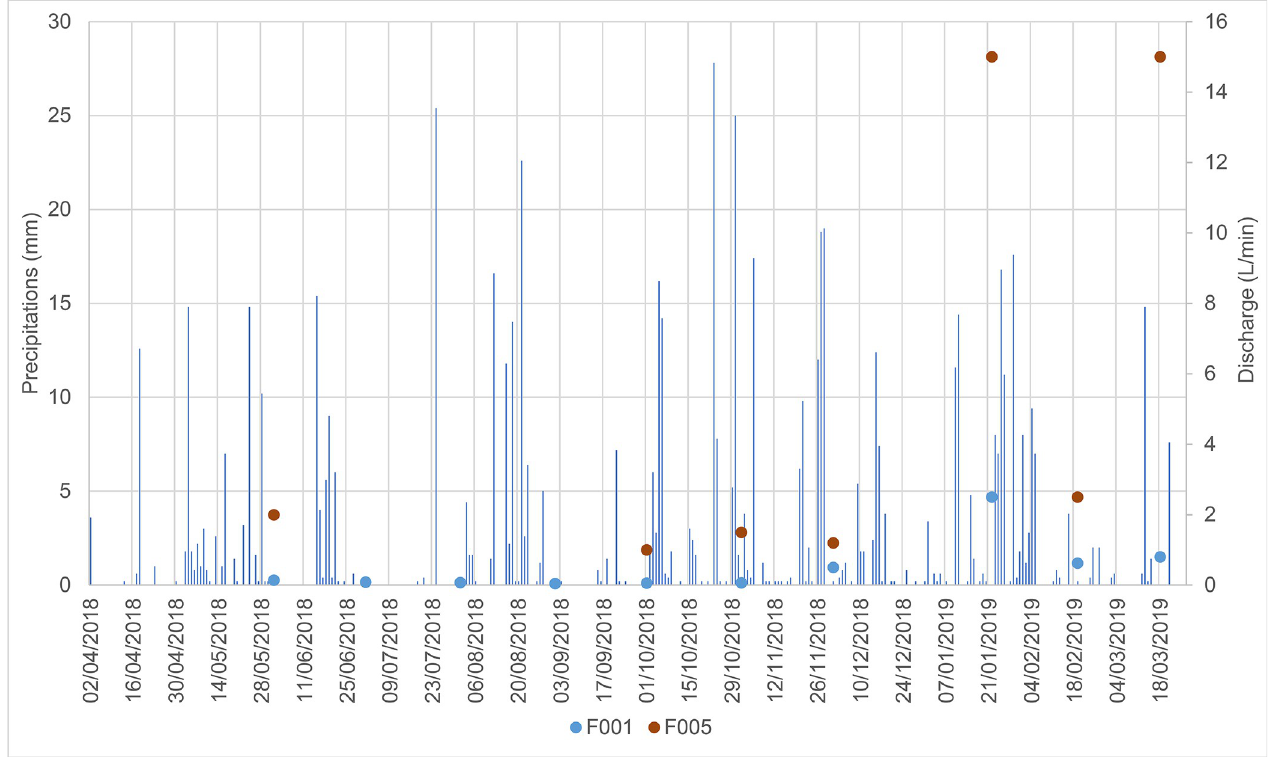
Fig 6. Discharge measured at F001 (upstream) and F005 (downstream) along a single stream.